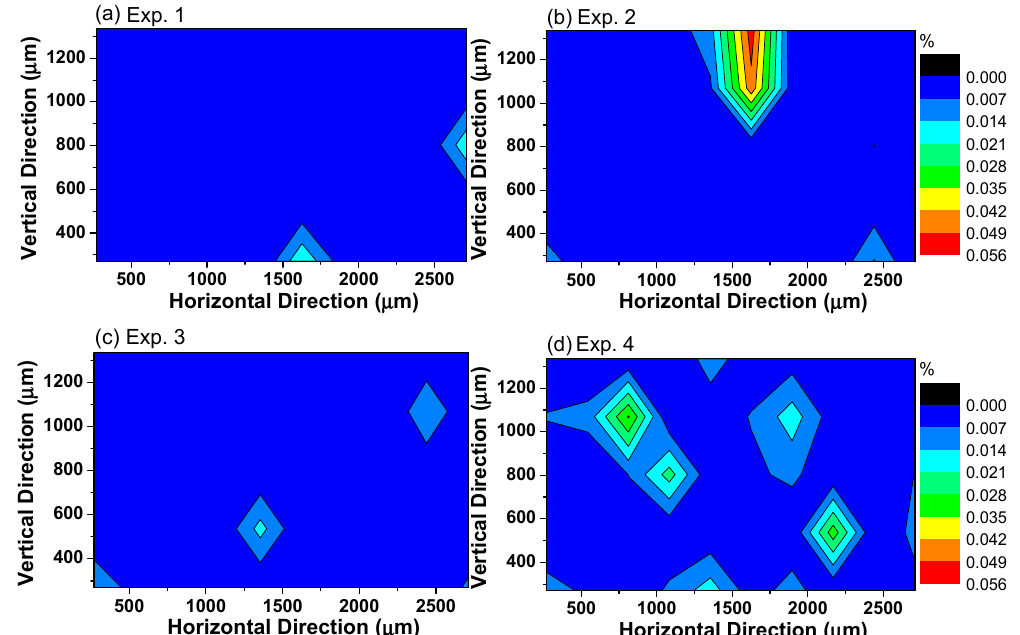
Figure 8. Density distribution of inclusions on the cross section in each experiment.